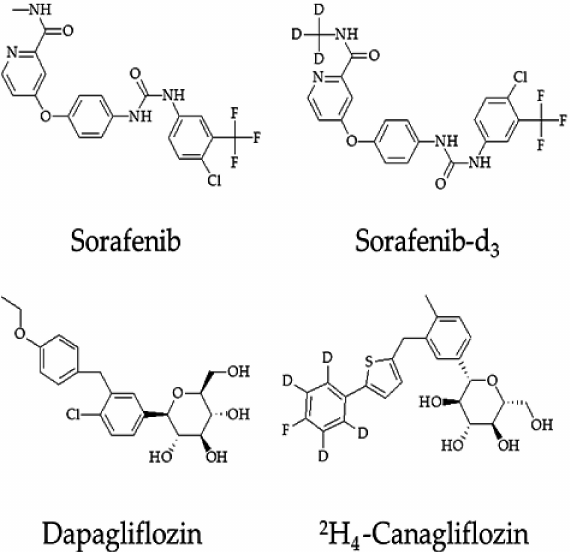
Figure 1. Chemical structure of Sorafenib, Sorafenib-d 3 , Dapagliflozin, and 2 H 4